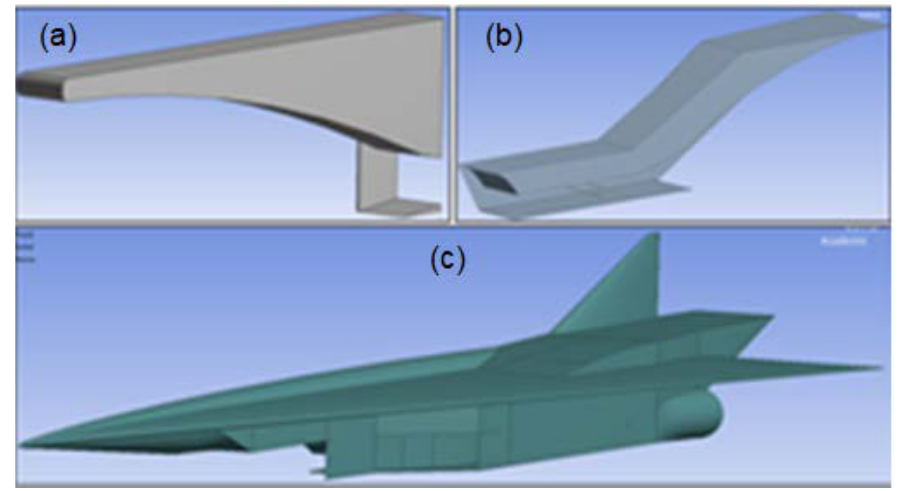
Figure 3. 3D geometries of ( a ) nozzle, ( b ) scramjet engine, and ( c ) aircraft and scramjet engine integration.